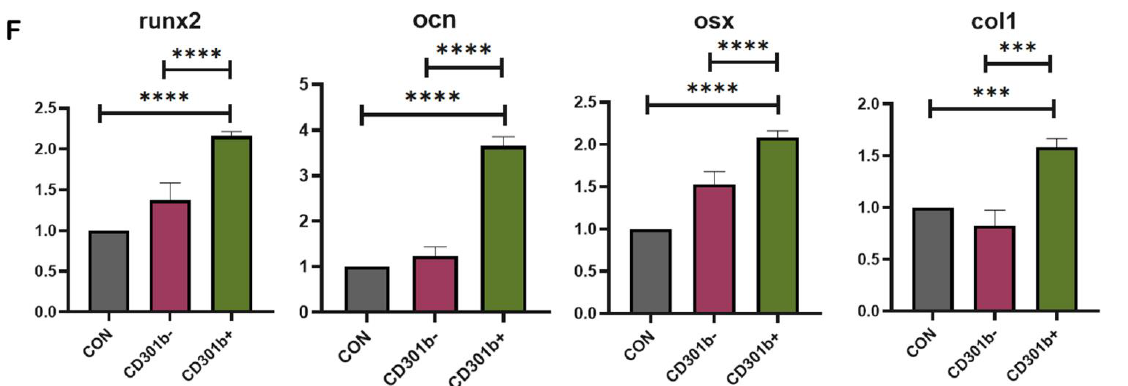
Figure 6. CD301b+ macrophages positively respond to mechanical forces, activate BMSCs, and promote osteogenesis of BMSCs under tension. ( A ) Cell migration assay. ( B ) Cell migration assay analysis. The area of the cell is shown as a percentage of the whole plot area. ( C ) CCK8 assay. ( D ) Morphological changes of BMSCs under tension. ( E ) ALP and alizarin red staining expression. ( F ) Levels of osteogenic-related genes (runx2, ocn, osx, col1a1) in BMSCs under tension after osteogenesis induction was detected using qRT-PCR. Values are presented as means ± SD. Note: *** p < 0.001, **** p < 0.0001; n = 3.